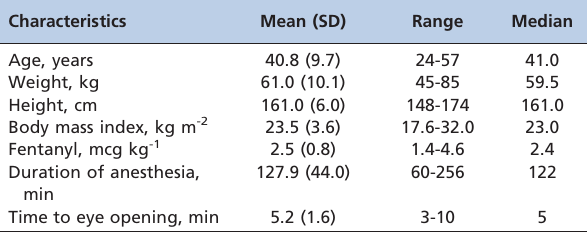
Table 1 - Characteristics of patients (N = 42).